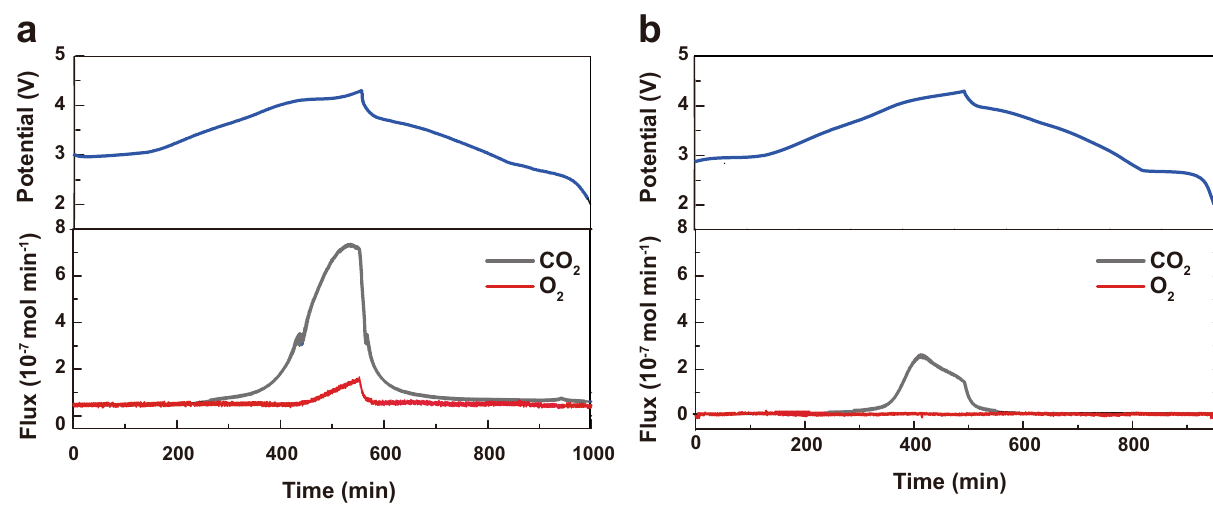
Fig. 8 Gas loss of NLNFM and NLNFMB during (de)sodiation. DEMS data collected during the fi rst cycle of NLNFM ( a ) and NLNFMB (